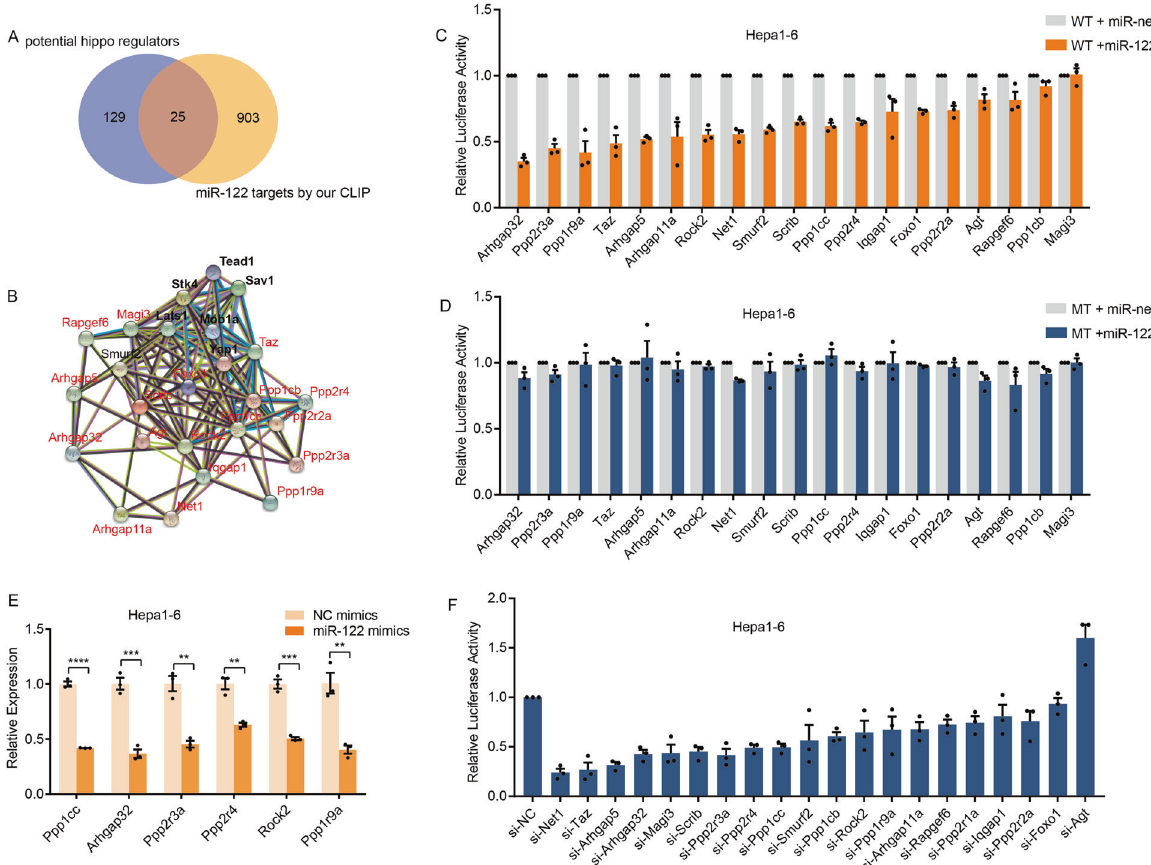
in 3 ′ UTR, CDS with miR-122 seed sequences. B Network analysis of miR-122 targets that may serve as Hippo pathway regulators, the interactions between proteins were analyzed using string database. The miR-122 targets are indicated by red font, and the core component genes of Hippo pathway are indicated by black font. C miR-122 target wild-type dual-luciferase reporter assay, values are mean ± SEM. D miR- 122 target mutant-type dual-luciferase reporter assay, values are mean ± SEM. E RT-qPCR showing the change of mRNA levels of targets after transfection of miR-122 mimics, values are mean ± SEM. F Hippo signaling pathway reporter assay after silencing potential miR-122 targets that may serve as regulator of Hippo pathway, values are mean ± SEM. (** p < 0.01; *** p < 0.001; **** p <